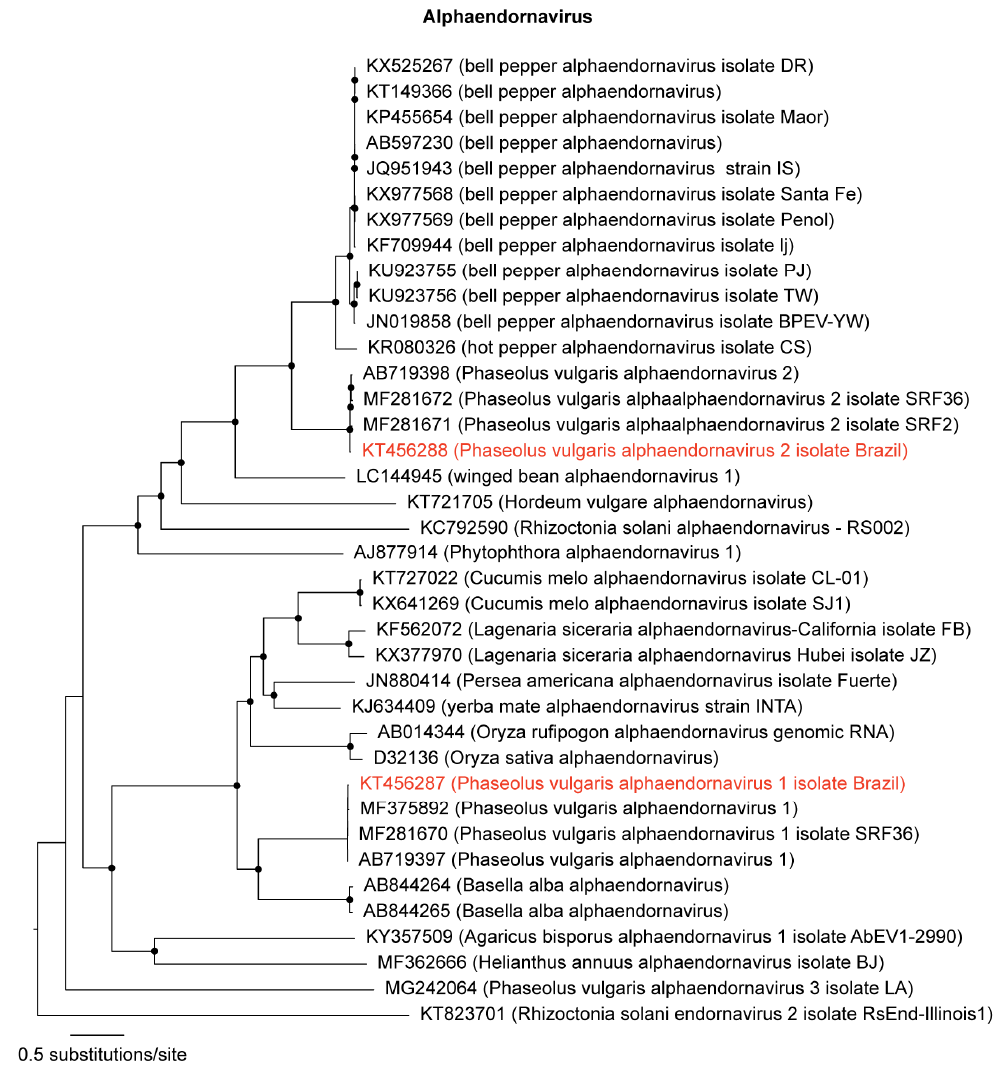
Figure 2. Maximum likelihood tree of alphaendornaviruses. The tree was inferred using an alignment of polyproteins from genomes of all members in the genus Alphaendornavirus available in GenBank. The tree is midpoint rooted for purposes of clarity, and the nodes indicated by a black dot have Shimodaira–Hasegawa-like branch test ≥0.9. The newly sequenced alphaendornaviruses are highlighted in red.